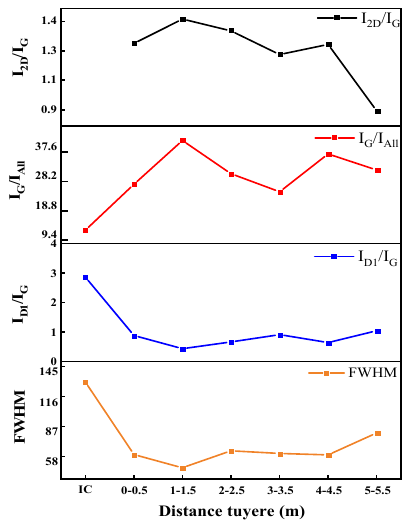
Figure 12. Characteristic peak area ratio and FWHM of IC and TC.